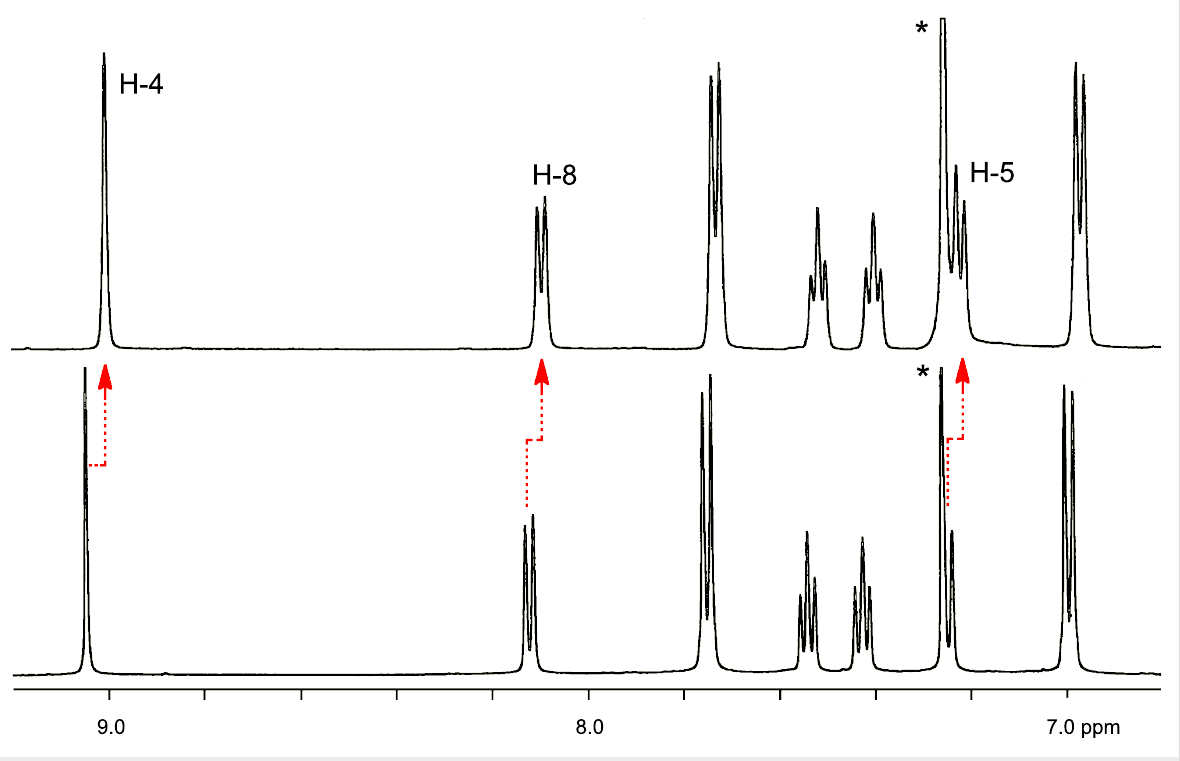
Figure 4: Aromatic region of the 1 H NMR (CDCl 3 , 500 MHz, 25 °C) spectra of macrocycle ( R , R ) - 12 (2.8 mM, bottom) and at the end of the titration with tetrabutylammonium succinate ([( R )- 7 ] = 2.8 mM, [(CH 2 CO 2 ) 2 (Bu 4 N) 2 ] = 28 mM, top). Asterisks indicate the residual solvent peaks.